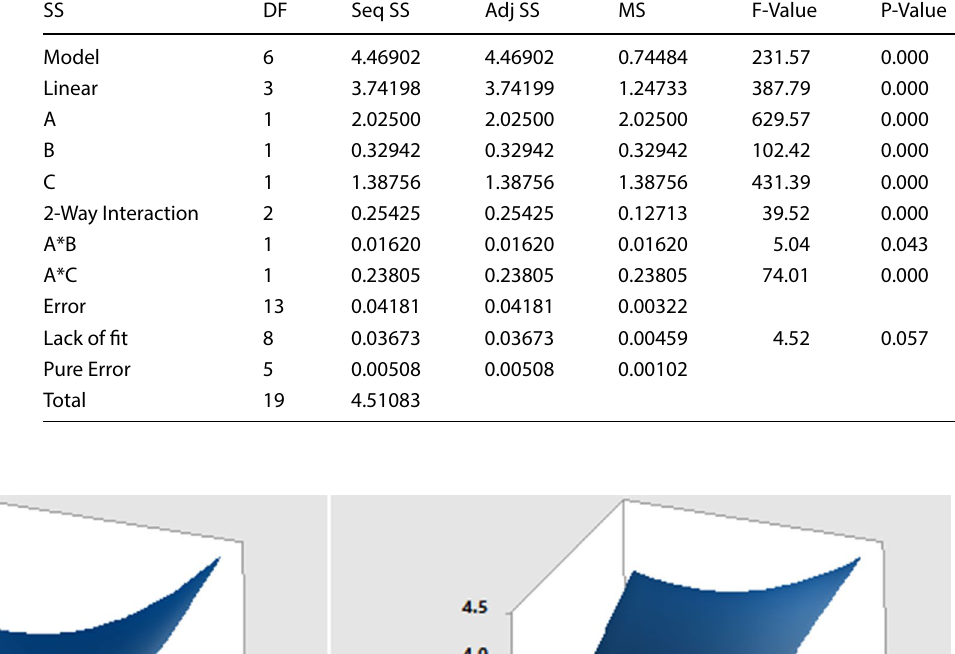
Table 6 ANOVA for Ra of Al/ B C/Gr composite material 4